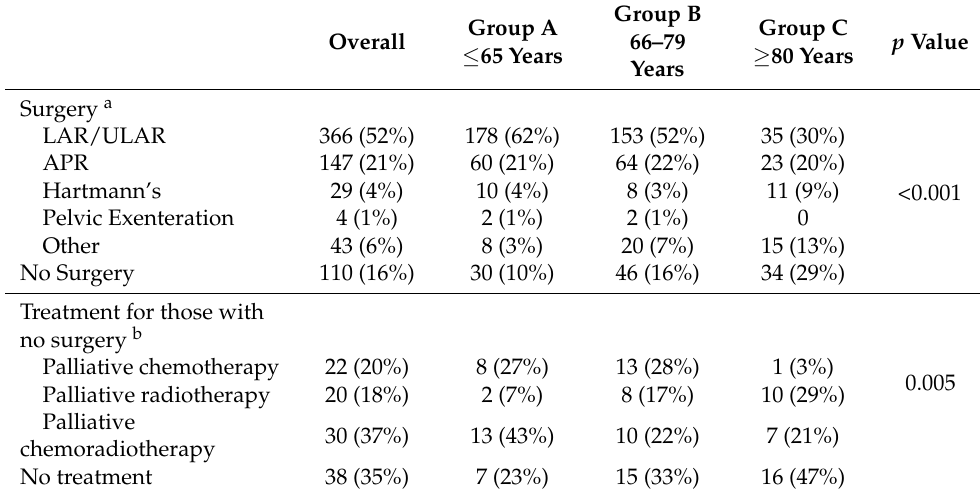
Table 2. Operative and non-operative treatment pattern for patients with rectal cancer across differing age